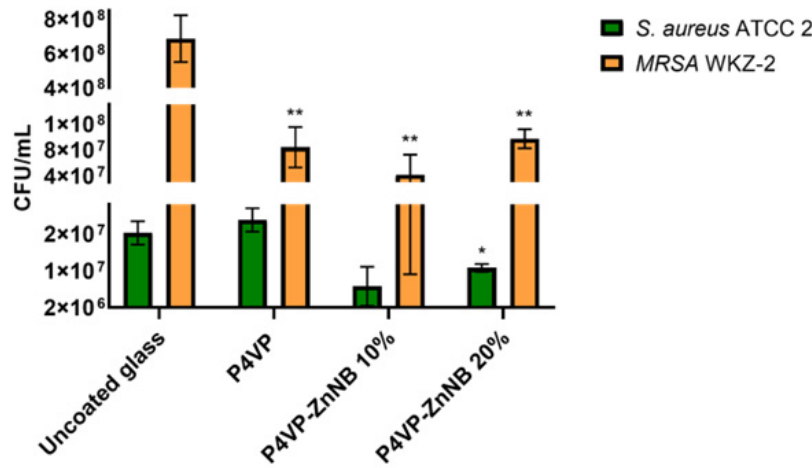
Figure 6. Effects of unfunctionalized P4VP and P4VP-ZnNB film functionalized with 10% or 20% ZnNB on S. aureus ATCC 29213 and methicillin-resistant S. aureus WKZ-2 bacterial strains. The assay was performed upon incubation of bacterial cells pressed on coated glass slides at 37 ◦ C overnight in a humidified chamber. The uncoated glass was tested as a control surface. The Student’s t -Test statistical analysis highlighted significant differences between treated and control samples (** p <